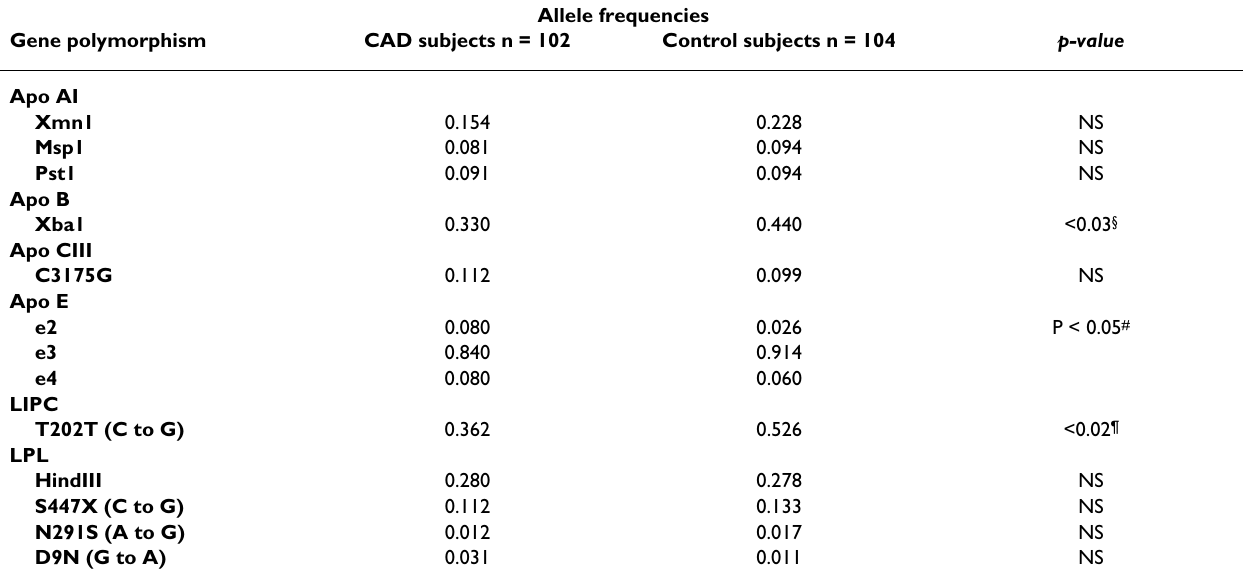
Allele frequencies